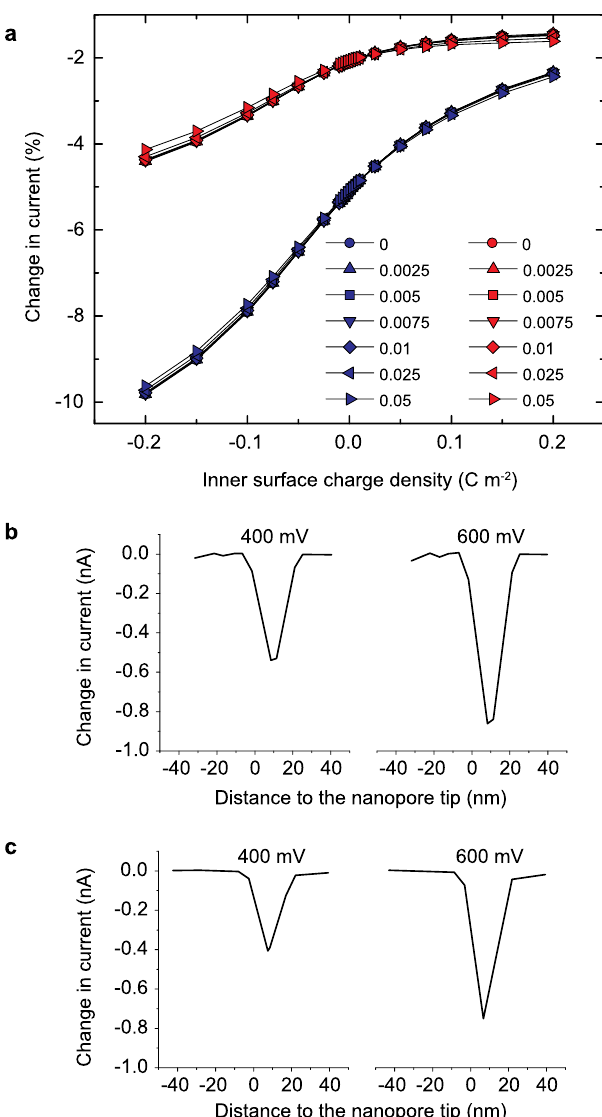
Fig. 7 Finite-element-method simulation of the resistive signals. a FEM simulated normalized change in current for a dsDNA molecule (blue) and a ssDNA molecule (red) translocating through the axis of a nanopore in function of the inner (horizontal axis) and outer (symbol shape) surface charge density at 500 mV. Note that dsDNA molecules always lead to higher current drops than their single stranded counterparts, as they have higher cross-section areas. b FEM simulated current drops for single stranded molecules translocating through the walls of the nanopore at 400 and 600 mV. c FEM simulated current drops for double stranded molecules translocating through the axis of the nanopore at 400 and 600 mV. Note that ssDNA molecules translocating through the pore walls present comparable resistive signals with their double stranded counterparts translocating through the bulk of the nanopore, in agreement with Figs. 3 and 5. Simulation details are presented in Supplementary Note